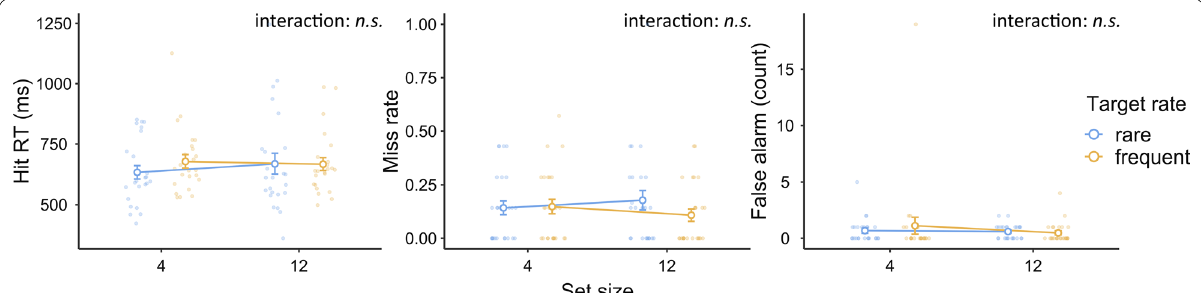
Fig. 11 Experiment 4 results: flash detection. Note In Experiment 4, we monitored the participants’ vigilance levels by asking them to detect occasional screen flashes. There were no significant target-rate effects on flash detection in terms of hit RT, miss rates, or false alarms. Error bars represent 1 standard error of the ±